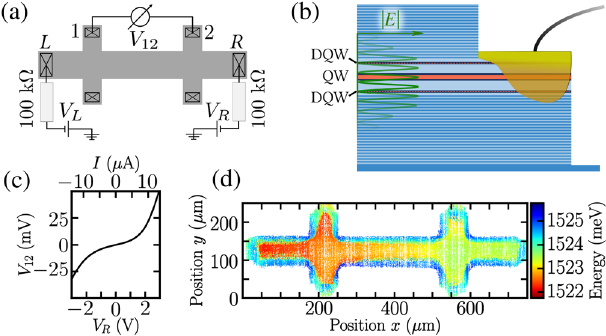
FIG. 1. Electrical and optical properties of the sample. (a) Layout of the Hall bar and the contacts. (b) Side view of the Hall bar. The top mirror has been etched to contact the 2DEG located in the center QW [doping quantum wells (DQW)]. (c) Current-voltage characteristic of the device where V R acts as current source and V L as drain. (d) Map of the lower polariton PL wavelength measured at normal incidence ( k k ¼ 0 ).